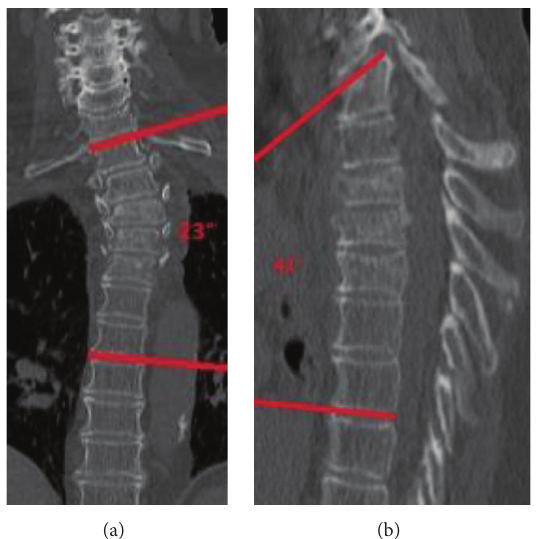
Figure 3: (a) CT scan showing the scoliosis and osteoporosis of the patient and the fractures in T3–T5. Cobb angle (T1–7): 23 ∘ . (b) CT scan in the sagittal profile. Kyphosis angle (T1–7): 41 ∘ .